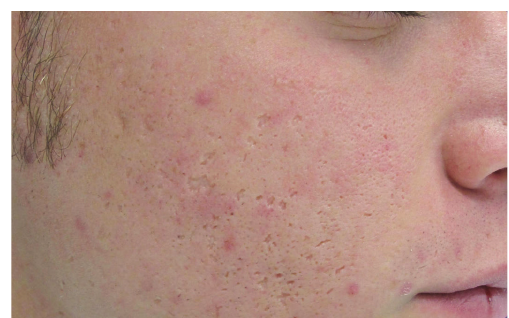
Figure 5: TCA Cross: patient after the